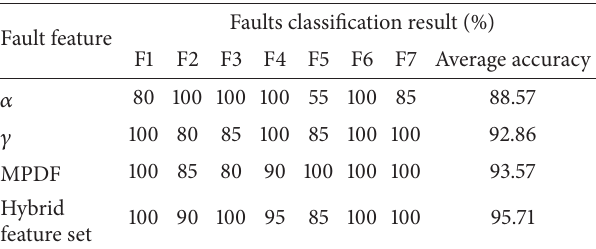
Table 6: Fault diagnosis result of the proposed fault diagnosis method based on S 𝛼 S and